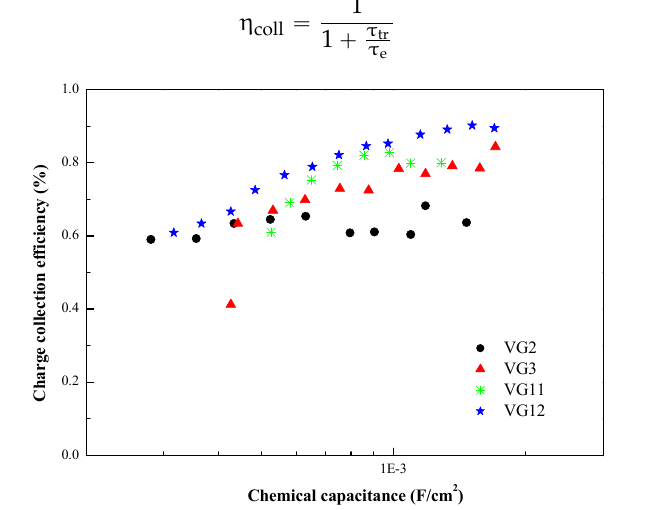
Figure 8. Evolution of the charge collection efficiency as a function of device chemical capacitance (C µ ) for VG2-C8, VG3-C8, VG11-C8 and VG12-C8 dyes.